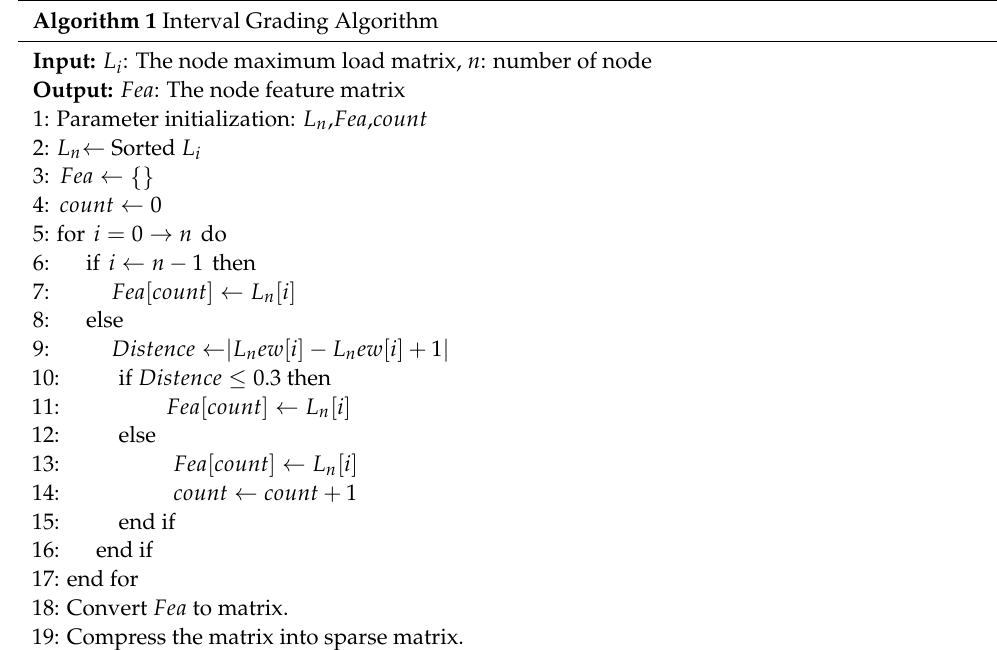
Algorithm 1 Interval Grading